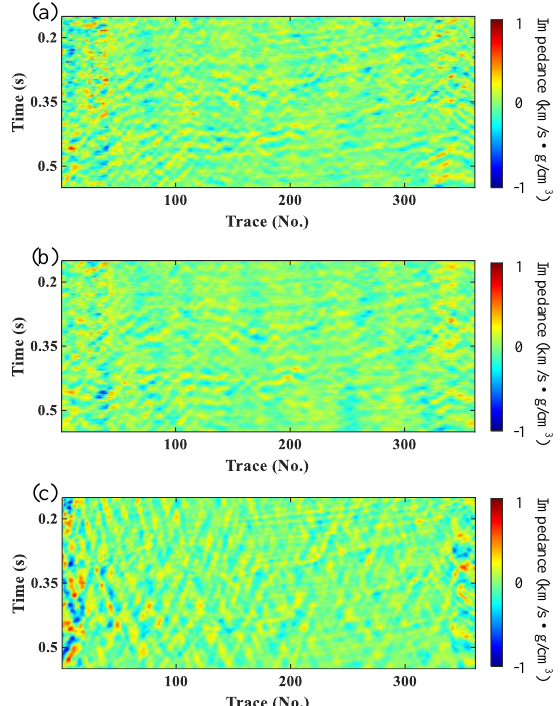
Figure 10. ( a ) The inverted impedance using SSII without f-x filtering. ( b ) The inverted impedance using SSII with f-x filtering. ( c ) The inverted impedance using MSII without f-x filtering. ( d ) The inverted impedance using MSII with f-x filtering. ( e ) The inverted impedance using MDII without f-x filtering. ( f ) The inverted impedance using MDII with f-x filtering.